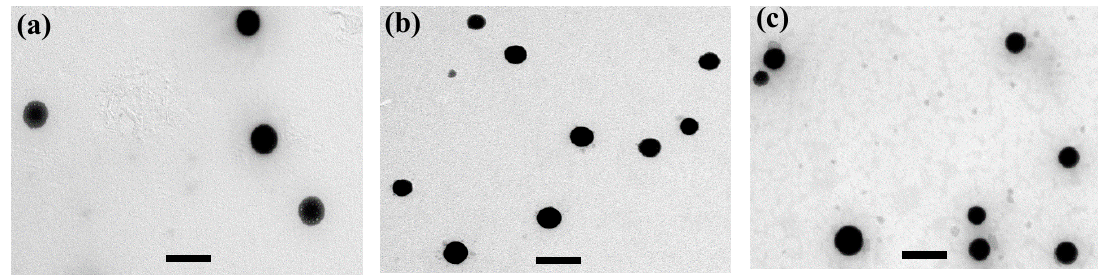
Figure 5. Transmission Electron Microscopy images taken at 26,500 × of the ( a ) star-poly(glutamic acid) (PGA) – Stromal-Derived Factor 1 α (SDF) 30:1, ( b ) star-PGA–SDF 40:1 and ( c ) star-PGA–SDF 50:1 nanoparticles. No obvious difference in morphology can be observed between the groups. Scale bar = 500 nm.